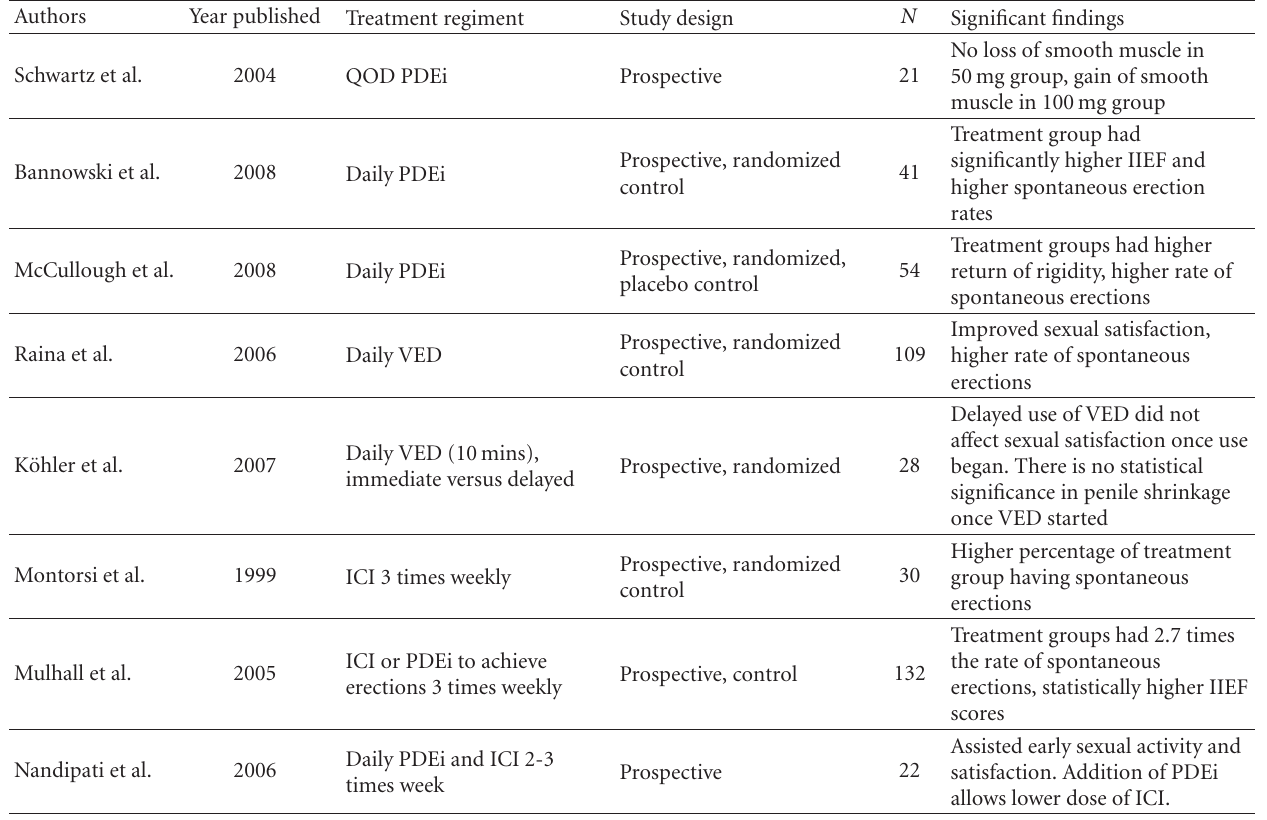
Table 1: Summary table of penile rehabilitation